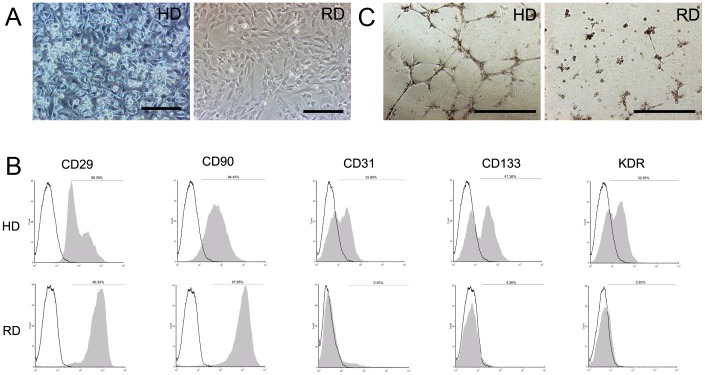
Endothelial progenitor cells enriched in HD cultured bone marrow cells.(A) Morphology of rat bone marrow cells in HD and RD culture. (Scale bars:100 µm). (B) Flow cytometry analyses of HD and RD cultured cells after 15 days of expansion. (C) Tube formation ability of RD and RD cultured cells on matrigel. (Scale bars:200 µm).